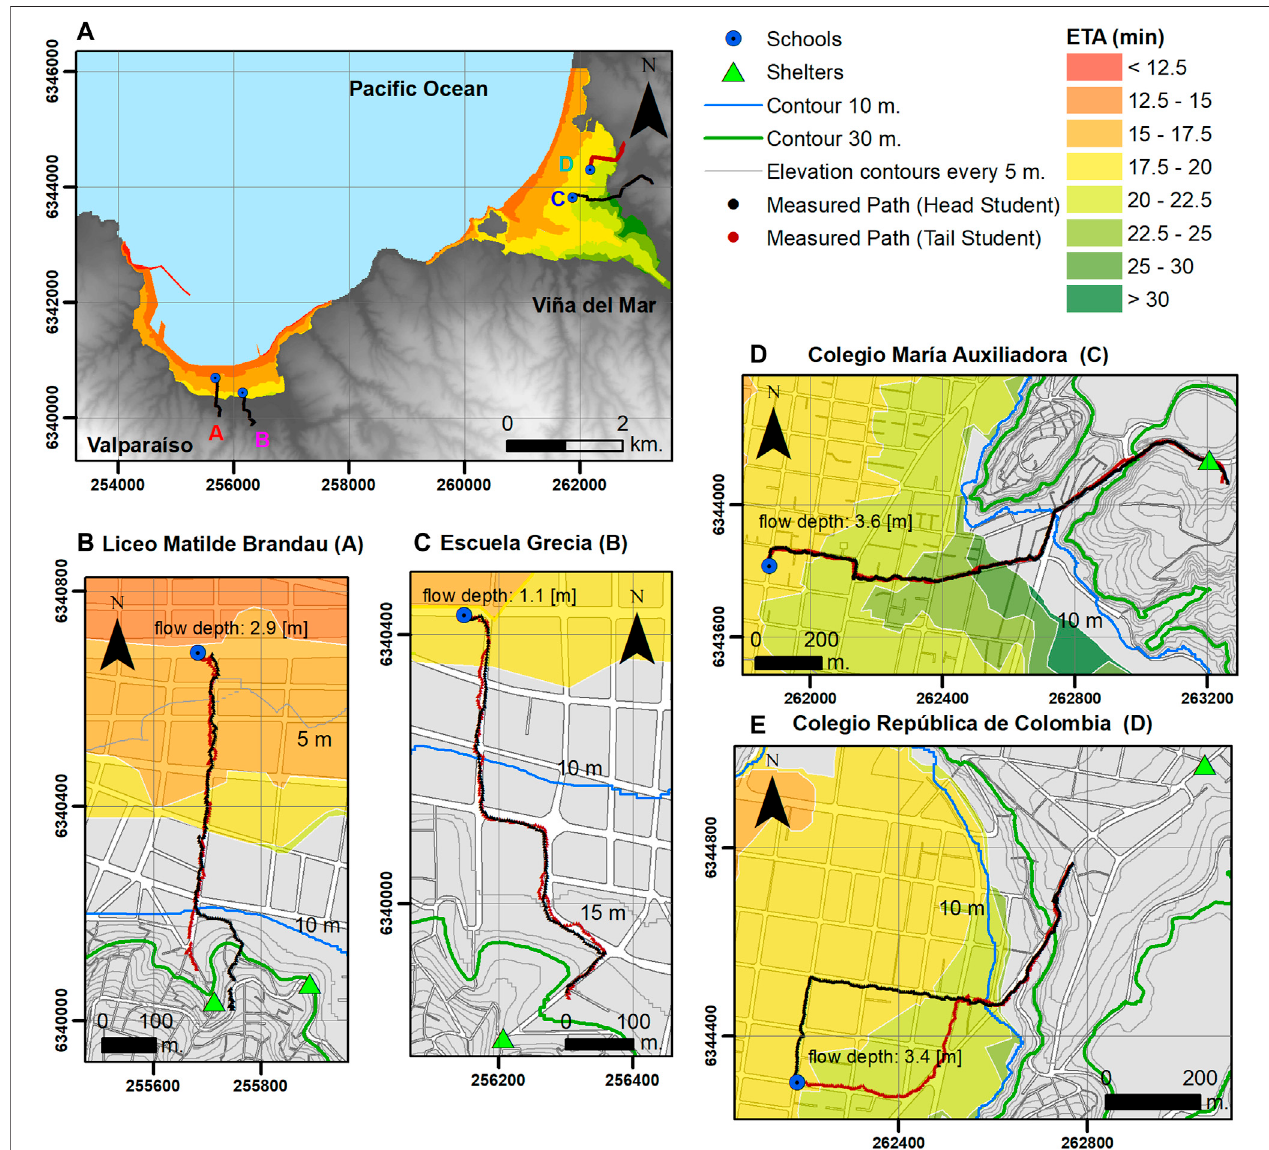
FIGURE 1 | Study areas in Valparaíso and Viña del Mar, including the estimated tsunami inundation area and arrival time, and the location of the four examined schools, their estimated inundation depths and their evacuation routes.